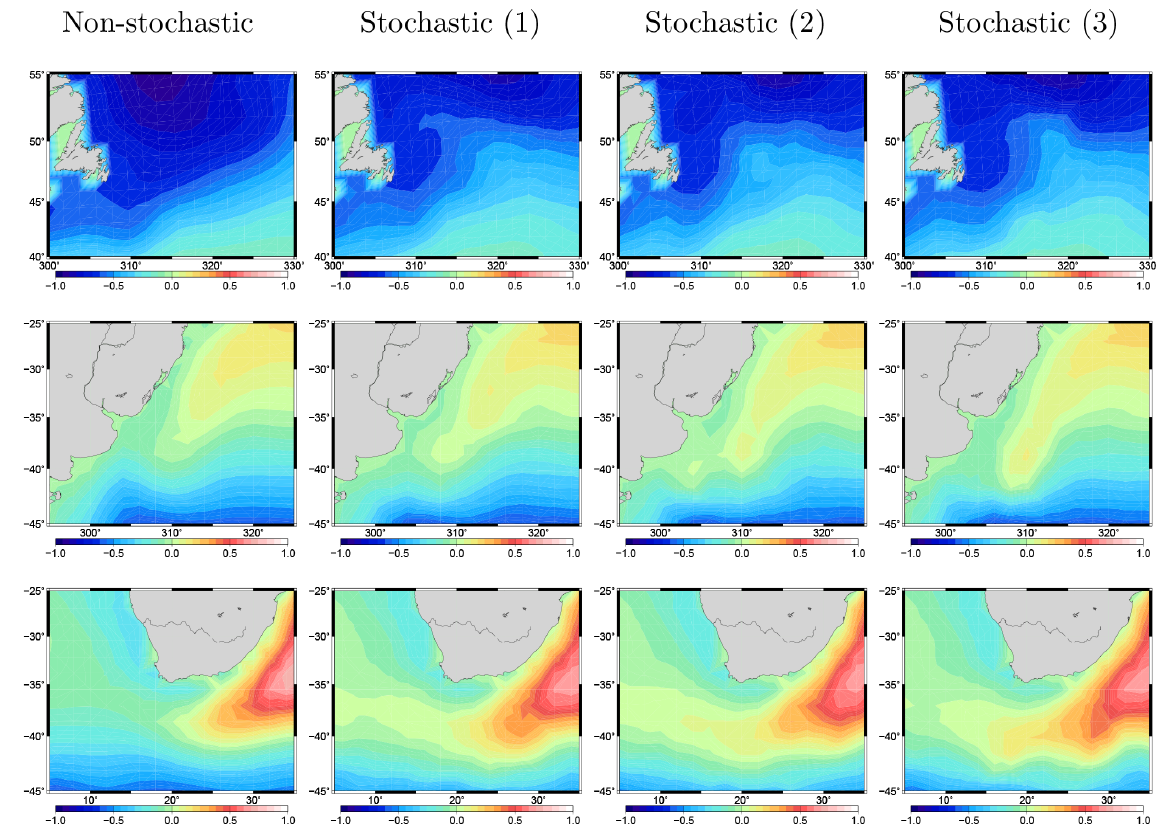
Figure 2. Sample of sea surface height patterns (in meters), illustrating the intrinsic interannual variability generated by the stochastic parameterization of the equation of state in a low-resolution global ocean model configuration (ORCA2): northwestern corner of the North Atlantic drift (top panels), Brazil–Malvinas Confluence Zone (middle panels), and Agulhas Current retroflection (bottom panels). For each region, the left panel represents the non-stochastic simulation, and the other panels are 3 different years of the stochastic